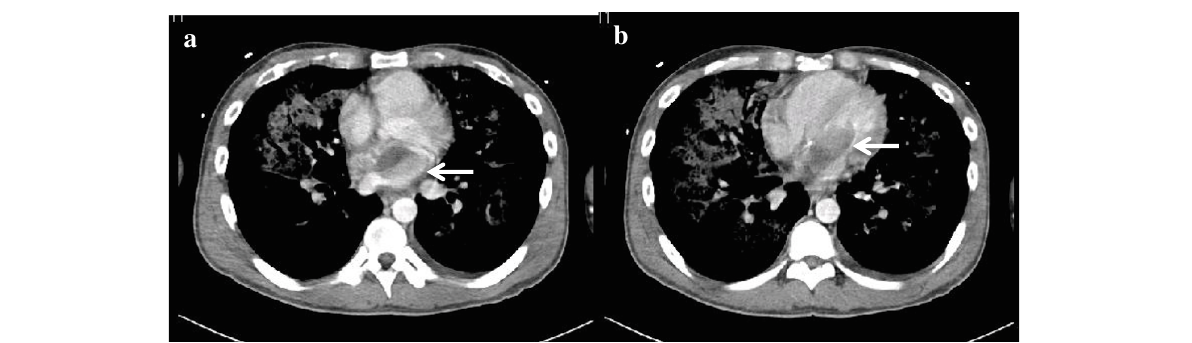
Fig. 1 Preoperative enhanced computed tomography scan. It revealed a large tumor in the left atrium (arrow) ( a ), incarcerating into the mitral annulus (arrow) ( b )